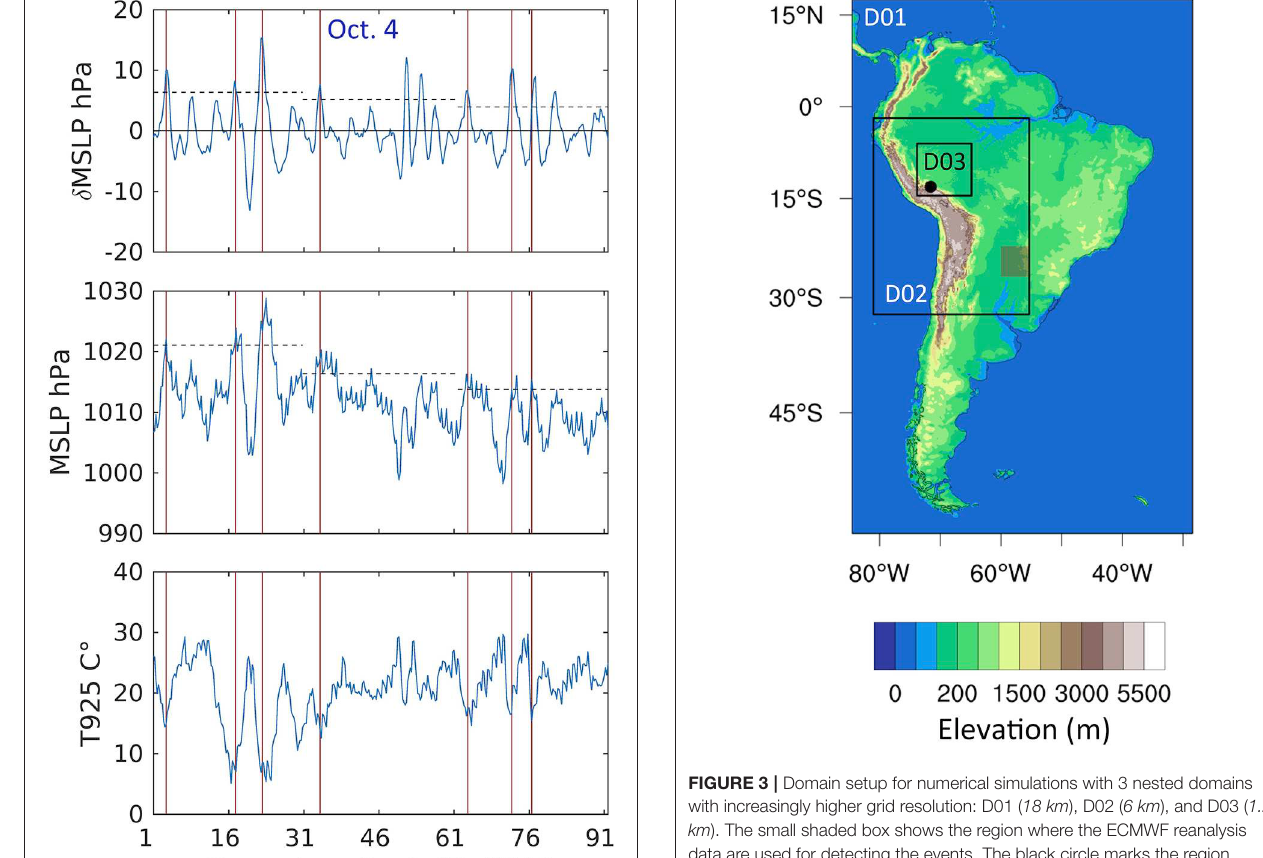
433 × 547 horizontal grid points, respectively ( Figure 3 ). The